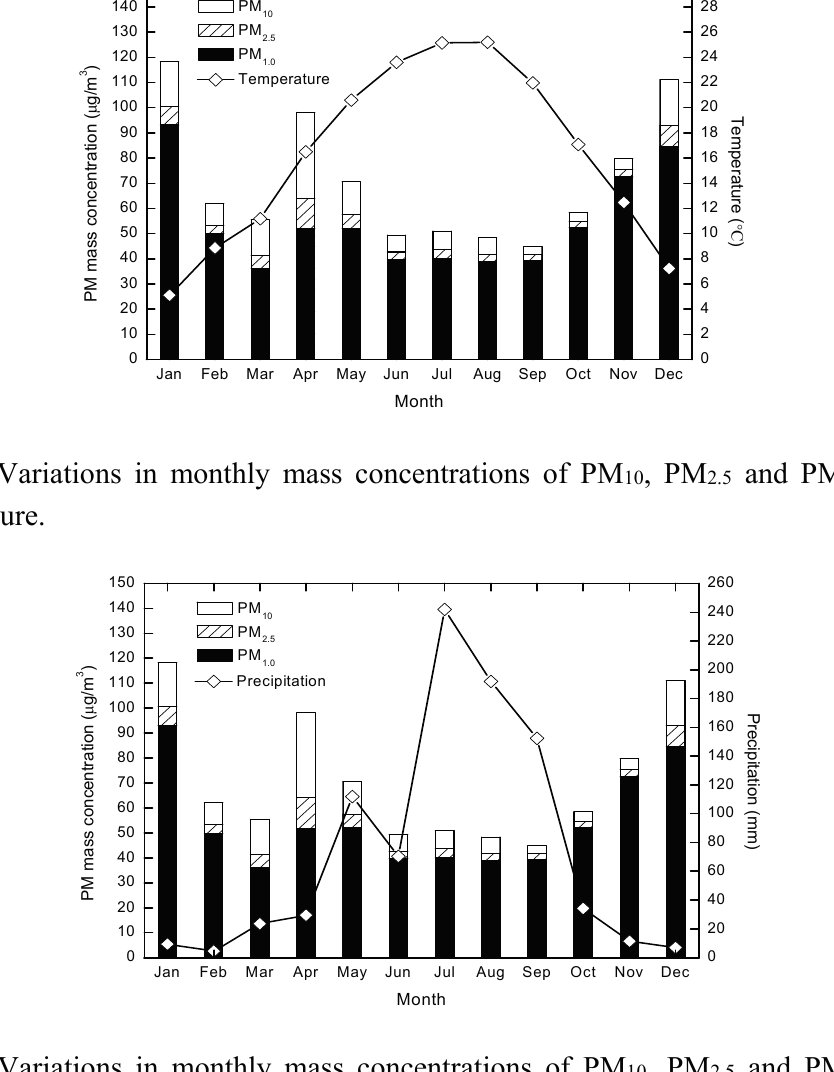
Figure 7. Variations in monthly mass concentrations of PM 10 , PM 2.5 and PM 1.0 related to